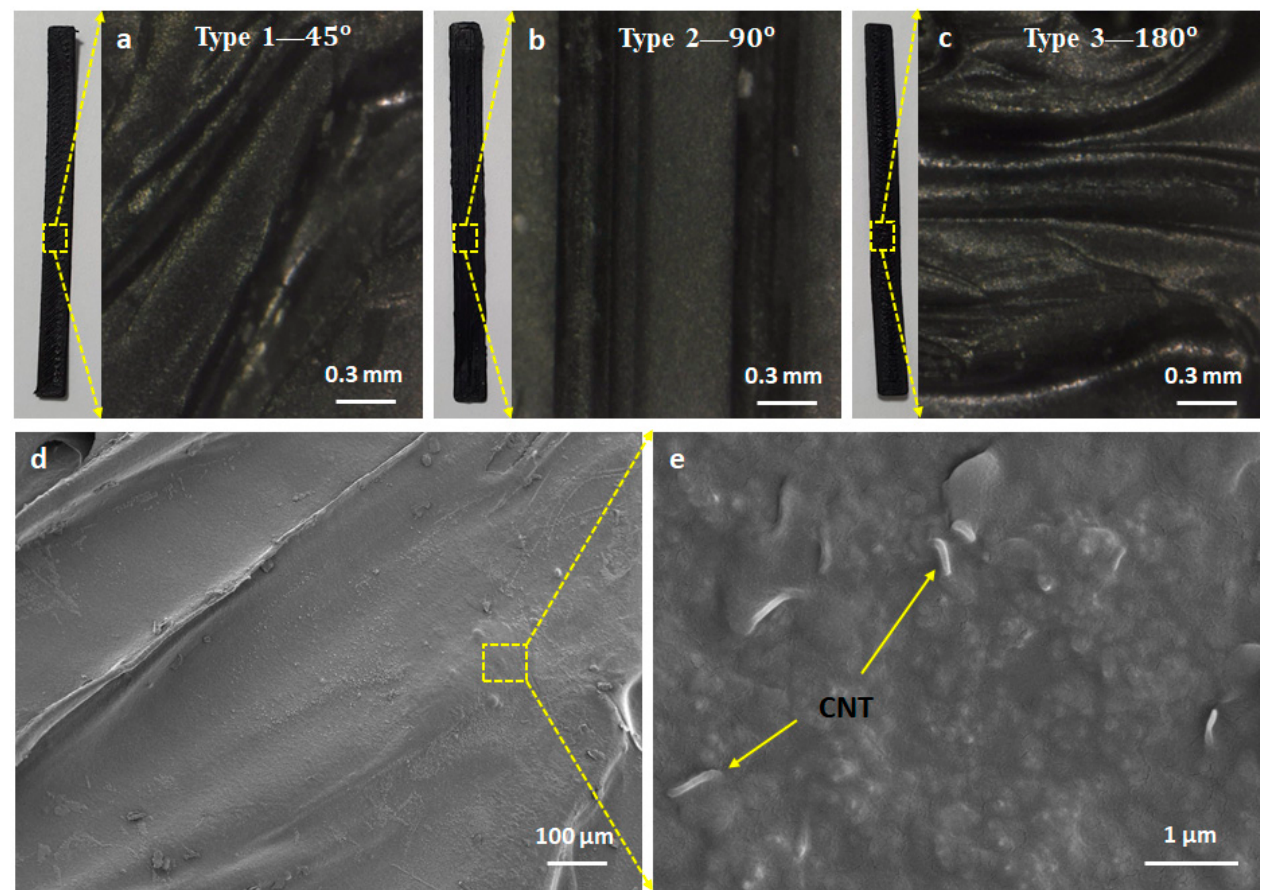
Figure 2. Scanning electron microscope (SEM) images of the sensors, consisting of ( a ) Type 1—45° at 0.3 mm, ( b ) Type 2—90° at 0.3 mm, ( c ) Type 3—180° at 0.3 mm, ( d ) SEM of the printing line at 100 µm, and ( e ) SEM of the printing line at 1 µm.